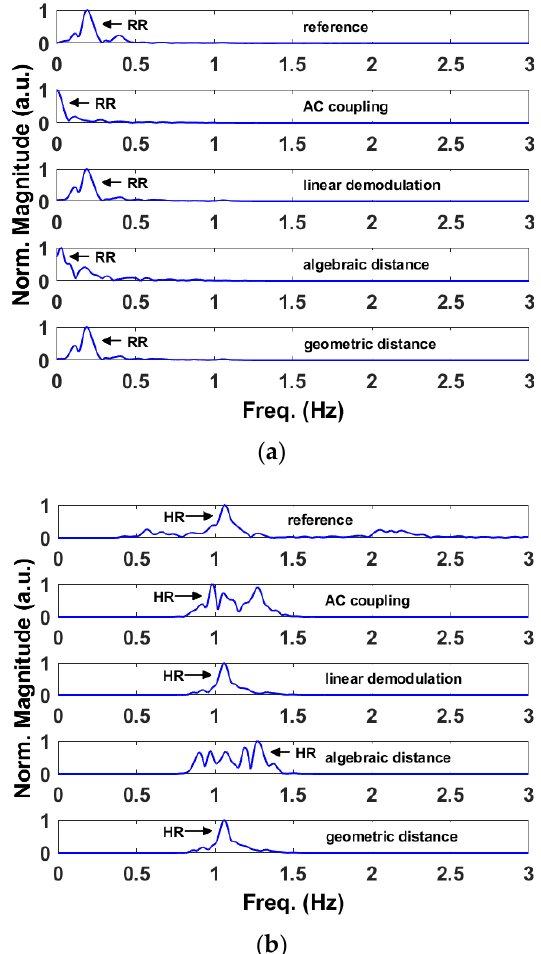
Figure 7. Example of baseband signals in the IQ plane obtained with the sub-10 GHz radar after applying the DC calibration methods. ( a ) Spectra obtained from the retrieved respiration signals. ( b ) Spectra obtained from the retrieved heartbeat signals.